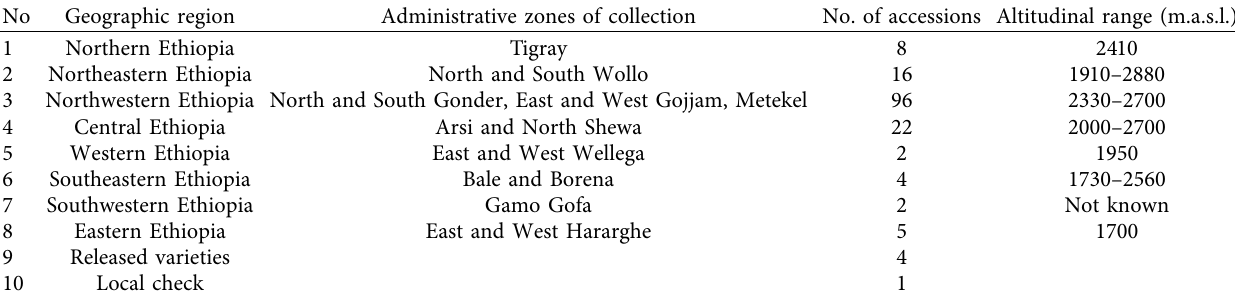
Table 1: Summary of fenugreek accessions collected from diferent geographic regions of